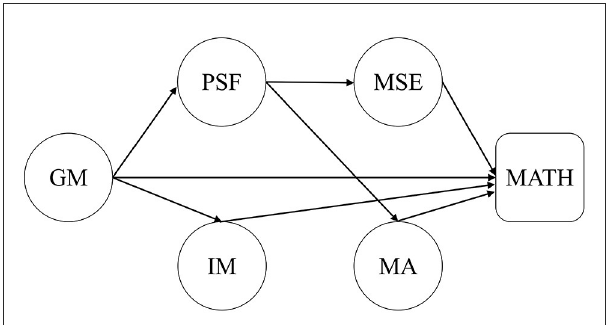
FIGURE1 Conceptual research model. GM, growth mindset; MSE, mathematics self-efficacy; IM, intrinsic motivation to learn mathematics; MA, mathematics anxiety; PSF, perceived self-responsibility for failing in mathematics; MATH, mathematics